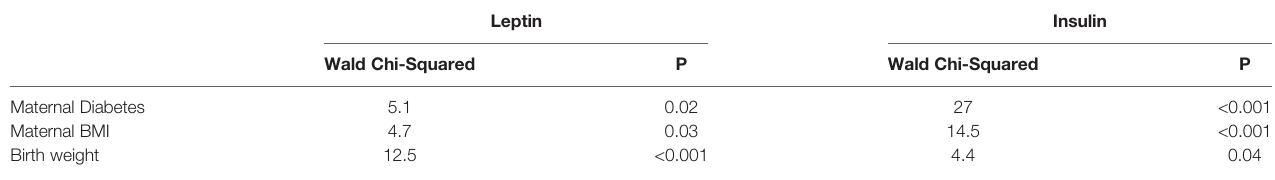
TABLE 3 | Generalized linear model with leptin or insulin as the dependent variable, maternal diabetes as a factor and maternal BMI or birth weight as potential covariates.